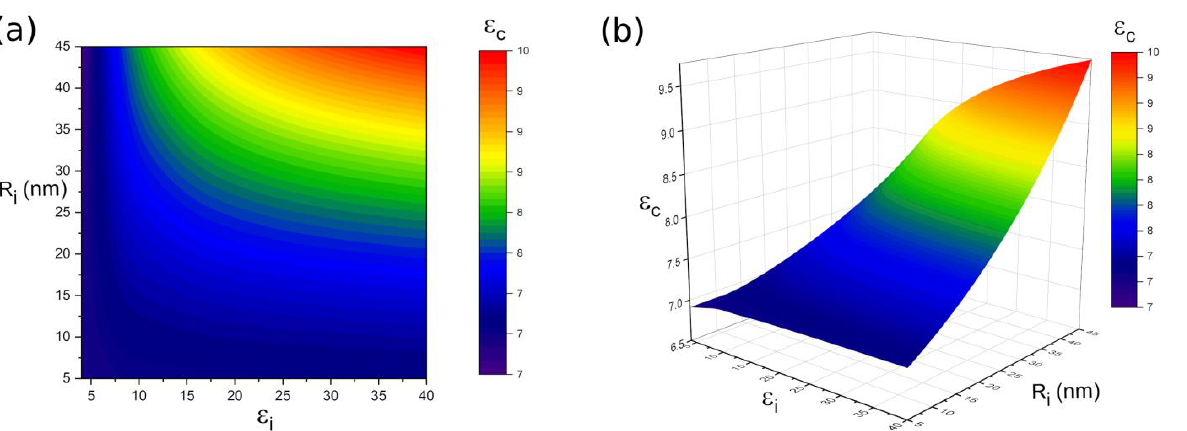
Figure 5. The dependence of ε c to the ε i and R i when ε f = 50, ε m = 6, R = 100 nm and V f = 0.1 ( a ) contour plot; ( b ) 3D plot.